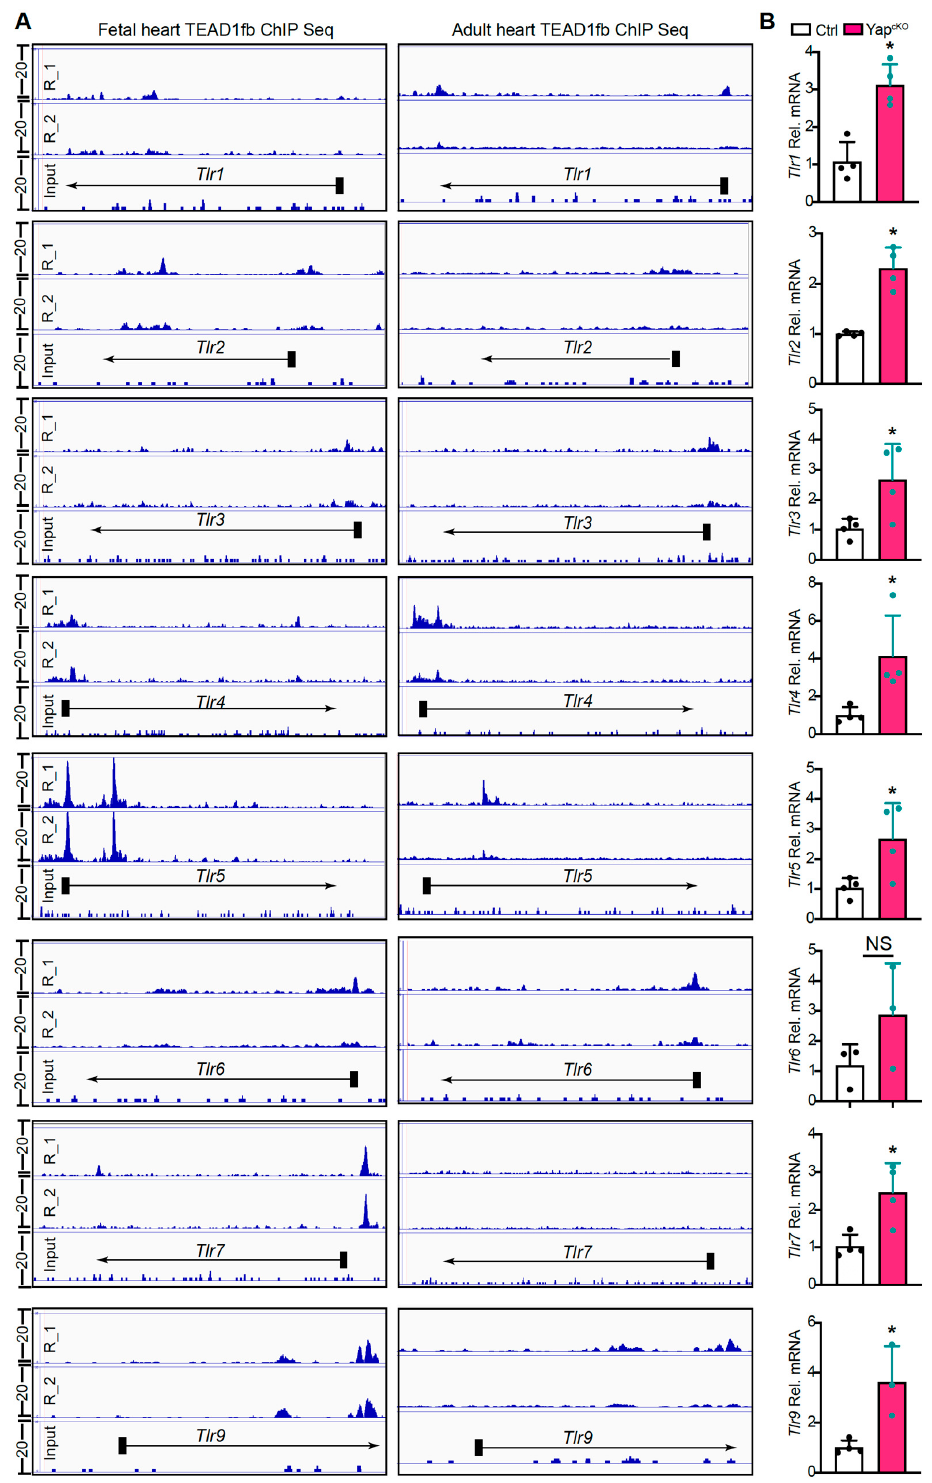
Figure 4. Cardiomyocyte-specific YAP depletion activates TLR genes expression. ( A ). Genome browser view showing chromatin immunoprecipitation and high throughput sequencing (ChIP-seq) of TEAD1 occupancy near the transcriptional start site (TSS) or gene body of the TLR genes. E12.5 fetal heart and adult hearts were used for TEAD1 fb ChIP-seq. ChIP-seq data from two biological replicates are sown. ( B ). qRT-PCR measurement of cardiac TLR genes. Gene expression level was normalized to Gapdh . n = 4. Student t -test, *, p < 0.05.